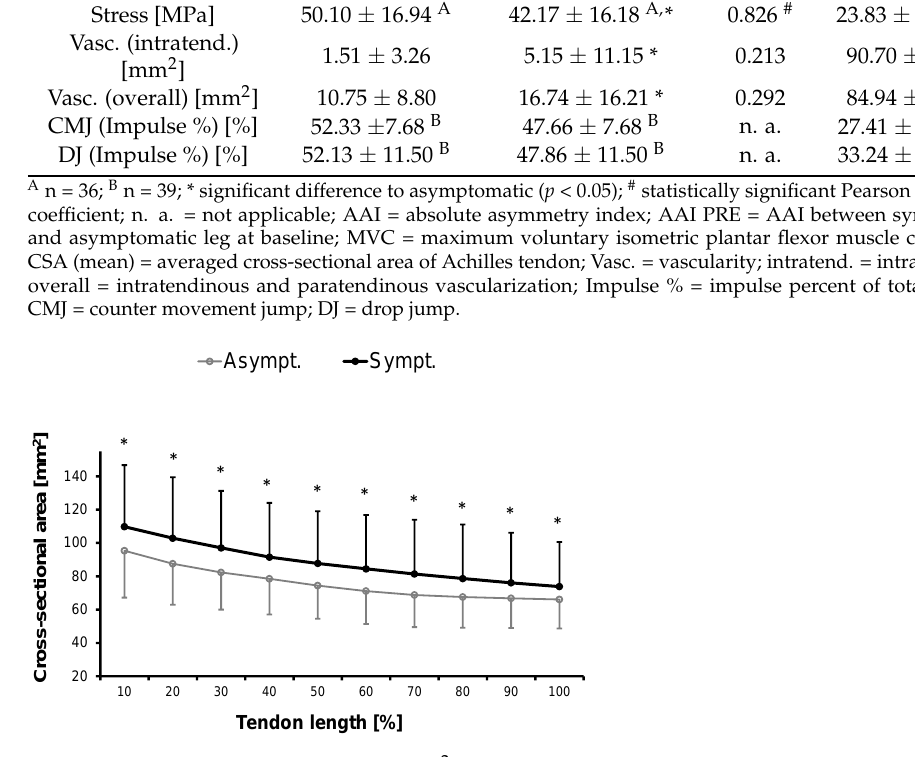
Figure 1. Cross-sectional area (CSA) (mm 2 ) of the asymptomatic and symptomatic Achilles tendon of the overall patient group at baseline (n = 36). The CSA was measured in 10% steps of tendon length from distal (0%) to proximal (100%) alongside the free Achilles tendon. * indicates significant difference when compared to the corresponding tendon region between legs ( p < 0.05).